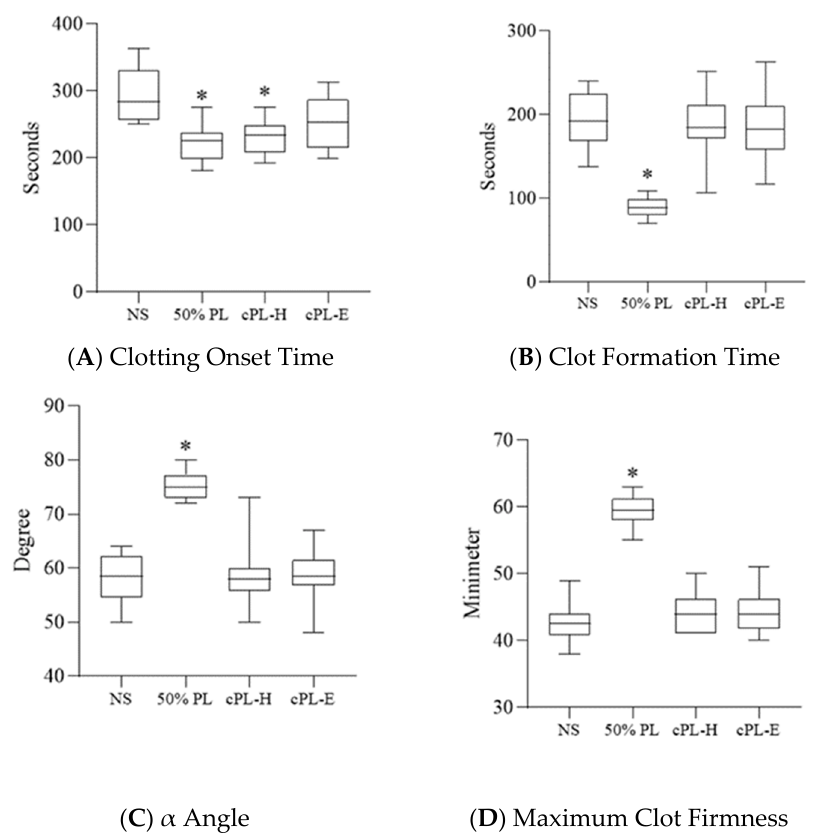
Figure 3. Effects of platelet lysate and fibrinogen-depleted platelet lysate on blood clot formation measured by rotational thromboelastometry. ( A ) Clotting onset time. ( B ) Clot formation time. ( C ) α angle. ( D ) Maximum clot firmness. In all experiments, n = 10 in each experimental group. * NS, normal saline; PL, platelet lysate; cPL-H, commercial platelet lysate-HELIOS; cPL-E, commercial platelet lysate-Evo. p < 0.001 versus the NS group in the Student’s t -tests.